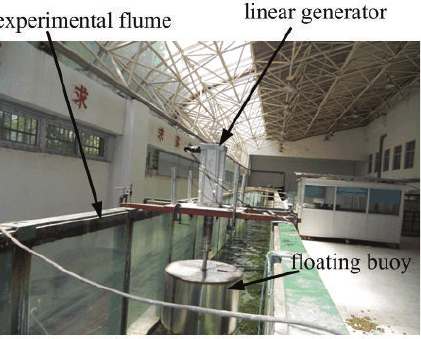
Figure 3: The wave energy extraction system in an experimental flume.